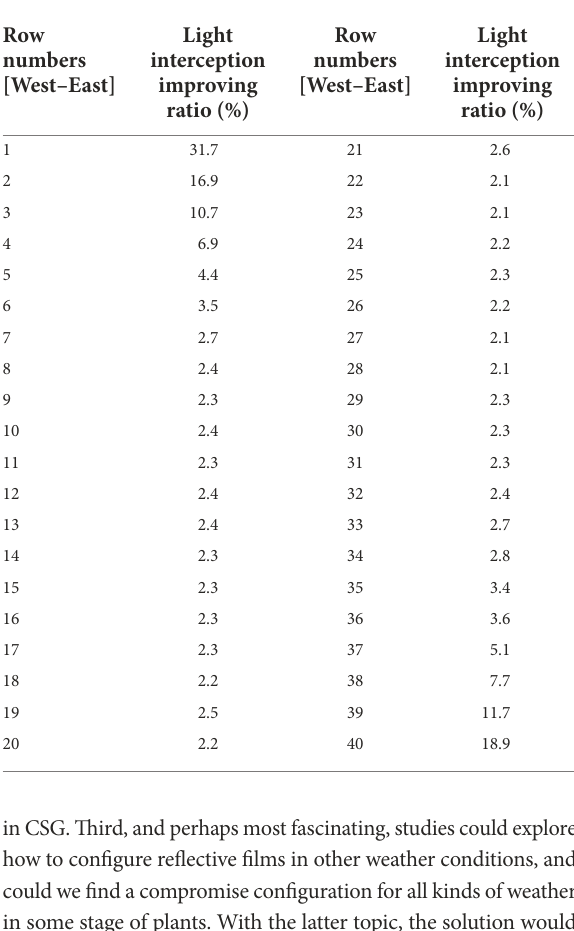
SUPPLEMENTARY FIGURE S1 Daily integrated effects of the inclination angle of reflective films on tomato canopy light interception of (A) west side and (B) east side of the greenhouse on December 30th. The inclination angle of the reflective films refers to the angle of the upper end of the reflective film tilting towards sidewalls.